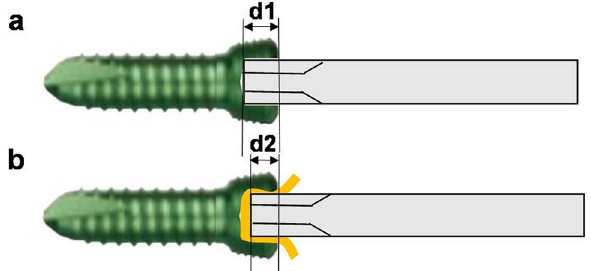
Figure 6. ( a ) The driver tip is engaged with the screw to its full depth (d1). ( b ) When the material is inserted into the screw socket, the driver tip may not be engaged until its full depth (d2 < d1), which can lead to a decrease in the contact